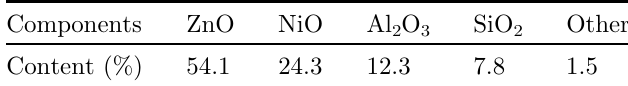
Table 2. Main components of